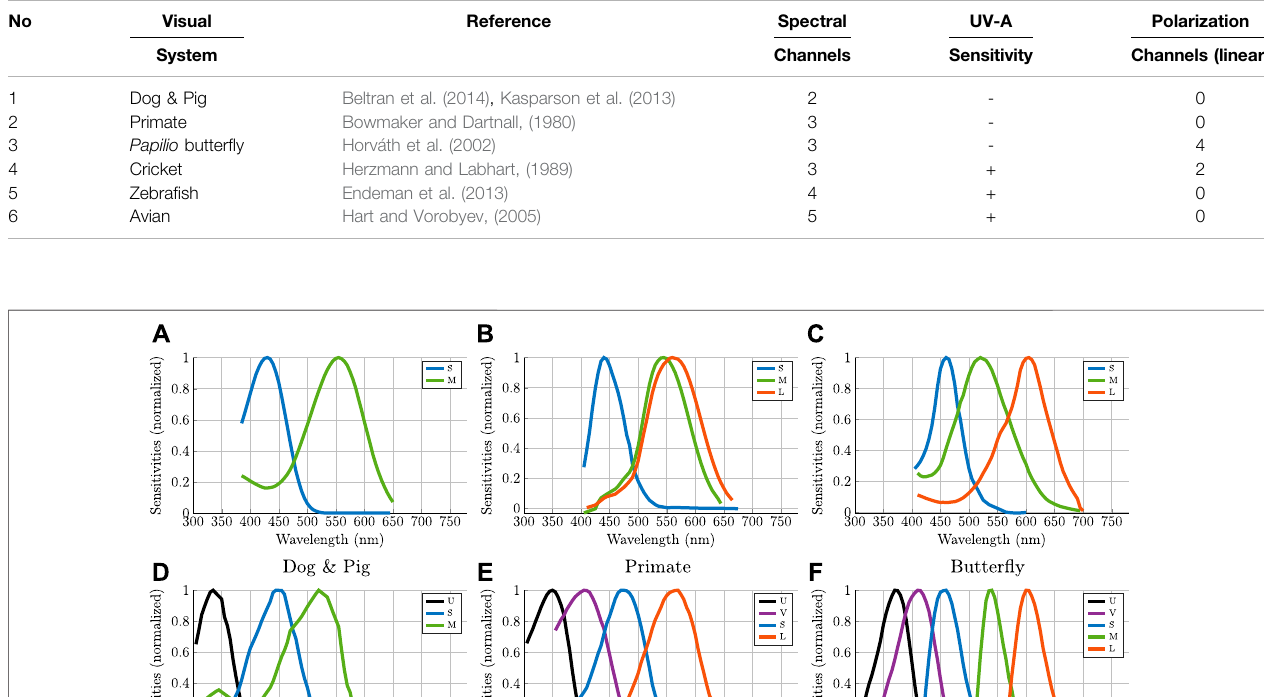
TABLE 1 | Summary of the visual systems. We used sensitivities presented in the literature from physiological studies of animal visual systems. Three of the animals are sensitive to the UV, and two are sensitive to polarization.